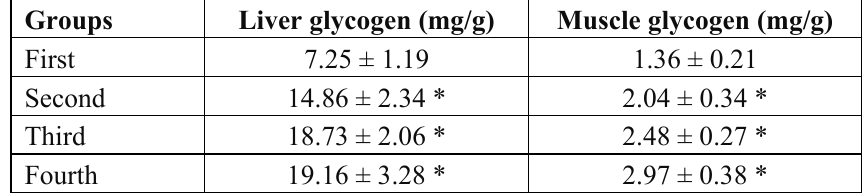
Table 1. The effects of TBE on tissue glycogen of mice. Values are means ± SD. * P < 0.05 when compared to the control group (first group).